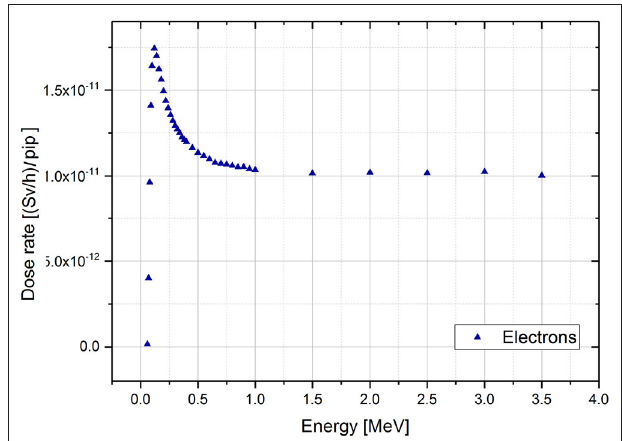
FIGURE 5 | Dose rate results of the MCNPX simulations for monoenergetic electron sources per incident particle (pip). The results for the e+ source provide a dataset that differentiates from the one of the e- of a factor minor that the 1 % and it has not been reported in the graph for